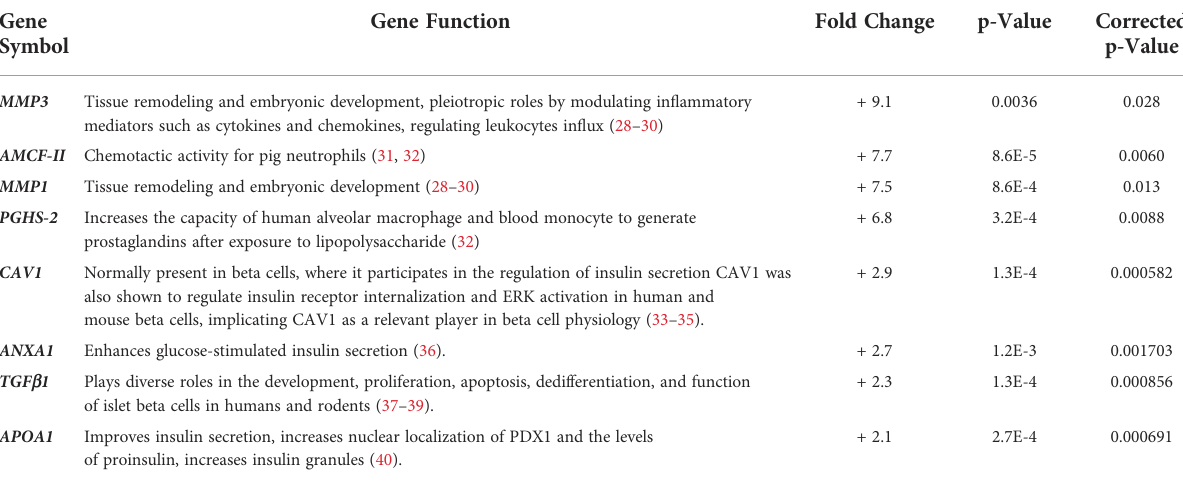
Gene Function Fold Change p-Value Corrected